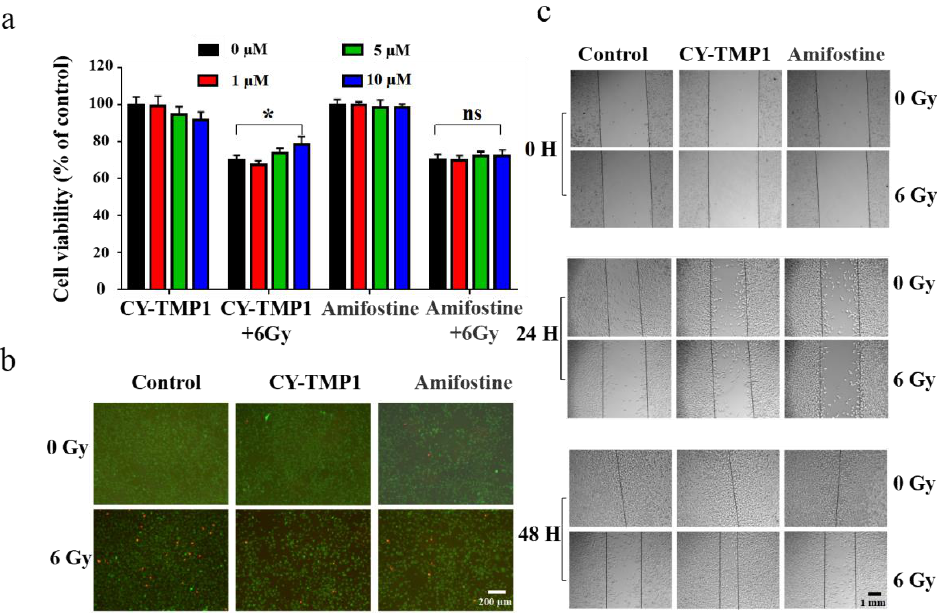
Figure 4. Radiation protection and wound scratch assay of CY-TMP1 on HFF-1 cells. ( a ) Radiopro- tective effect of CY-TMP1 on HFF-1 cells, n = 3, * p < 0.05; “ns” represents no significance; ( b ) Calcein AM (green) and PI (red) probes were utilized to stain live and dead HFF-1 cells before and after 6 Gy X-ray radiation; ( c ) Effect of CY-TMP1 (10 µ M) on the wound closure ability evaluated by a scratch assay of HFF-1 cells in the different treatment